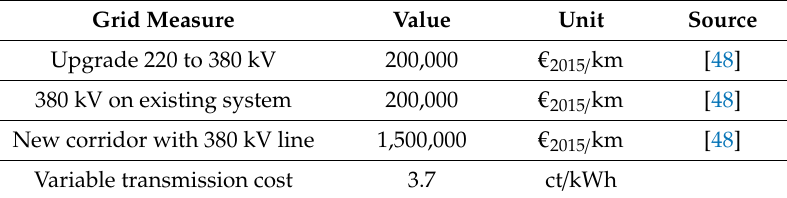
Table A5. Cost assumptions for the